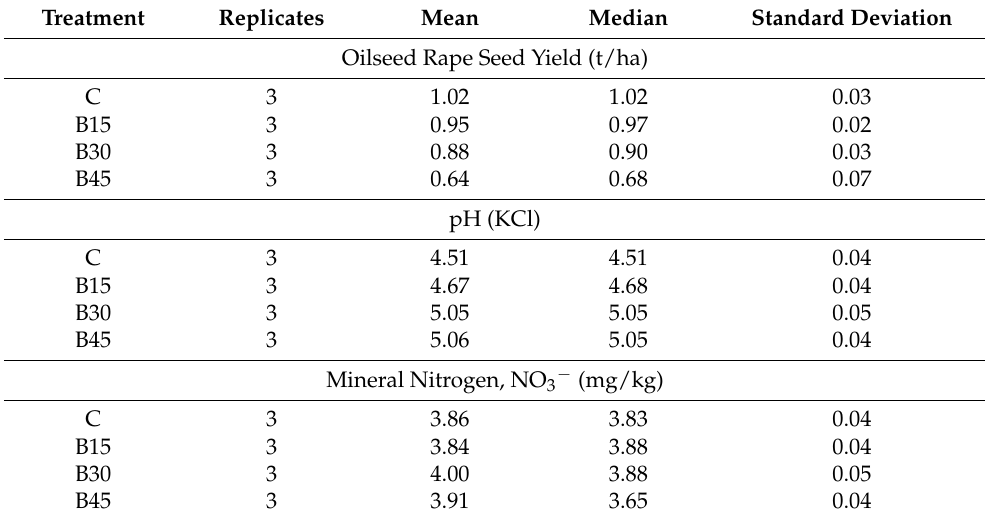
Table 3. Effect of biochar on the seed yield of oilseed rape, soil pH, and nitrate content. Treatment Replicates Mean Median Standard Deviation Oilseed Rape Seed Yield (t/ha)